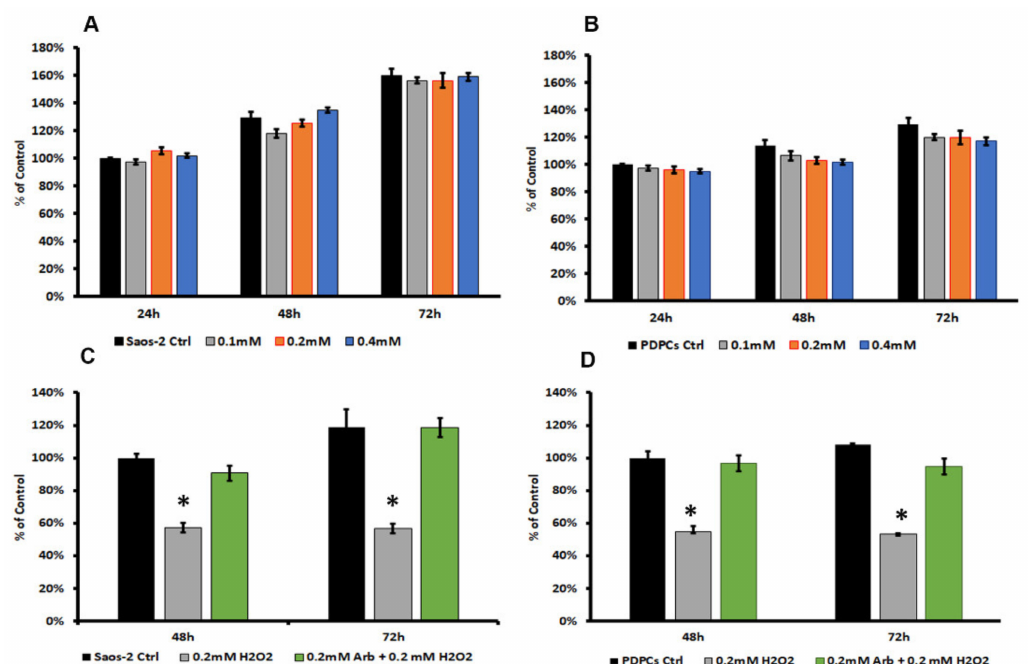
Figure 1. 3-dimethylthiazol-2,5-diphenyltetrazolium bromide (MTT) viability test: histograms of Saos-2 ( A ) and periosteal derived precursor cells (PDPCs) ( B ) cultured with di ff erent concentrations of arbutin for up to 72 h. Histograms of Saos-2 ( C ) and PDPCs ( D ) cultured with 0.2 mM of arbutin and exposed to oxidative stress (48 h = 24 h after stress induction, 72 h = 48 h after stress induction). Data are expressed as the percentage of Saos-2 or PDPCs cultured without arbutin after 24 h (control); * p < 0.05 vs.